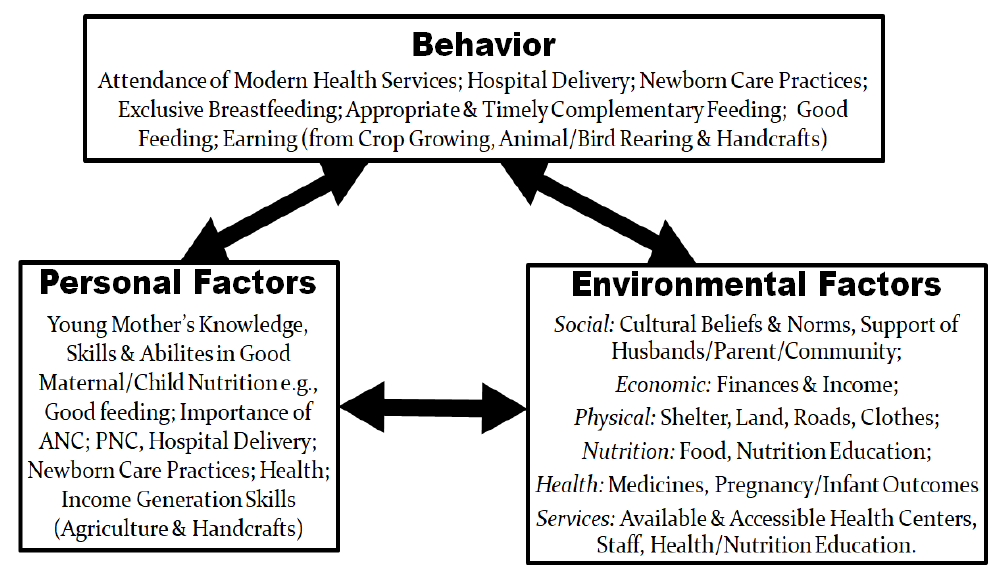
Figure 1. Social cognitive theory framework of perceived needs and barriers of adolescent maternal/child nutrition and